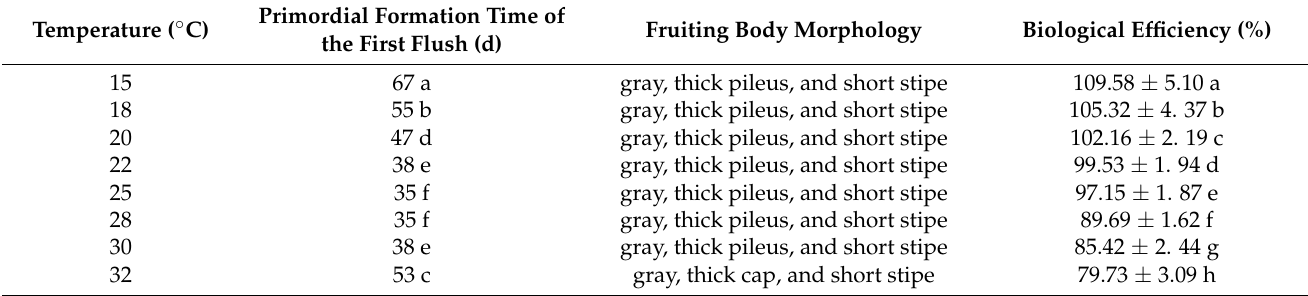
Table 2. Effects of mycelial culture temperature on fructification of P. ostreatus